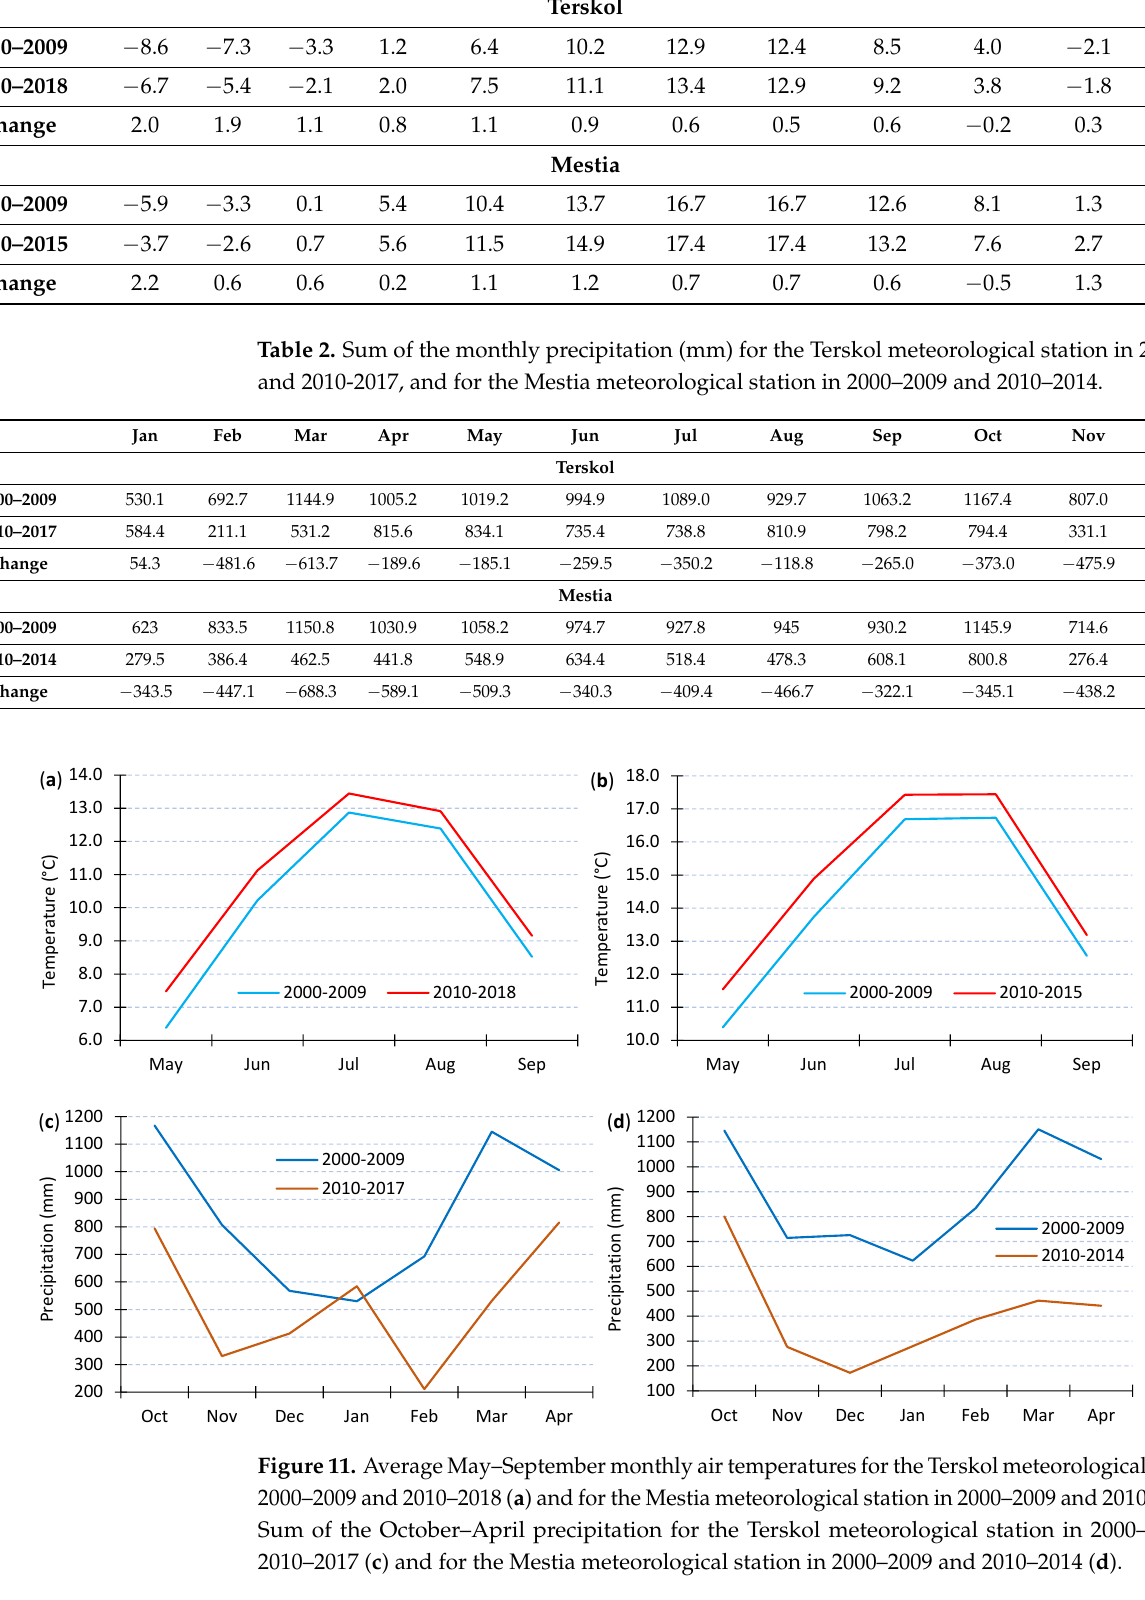
Figure 12 . Khasankoi glaciers (north-western Greater Caucasus) during the late summer without snowlines. Sentinel 2B image (04/09/2020) is used as a background.